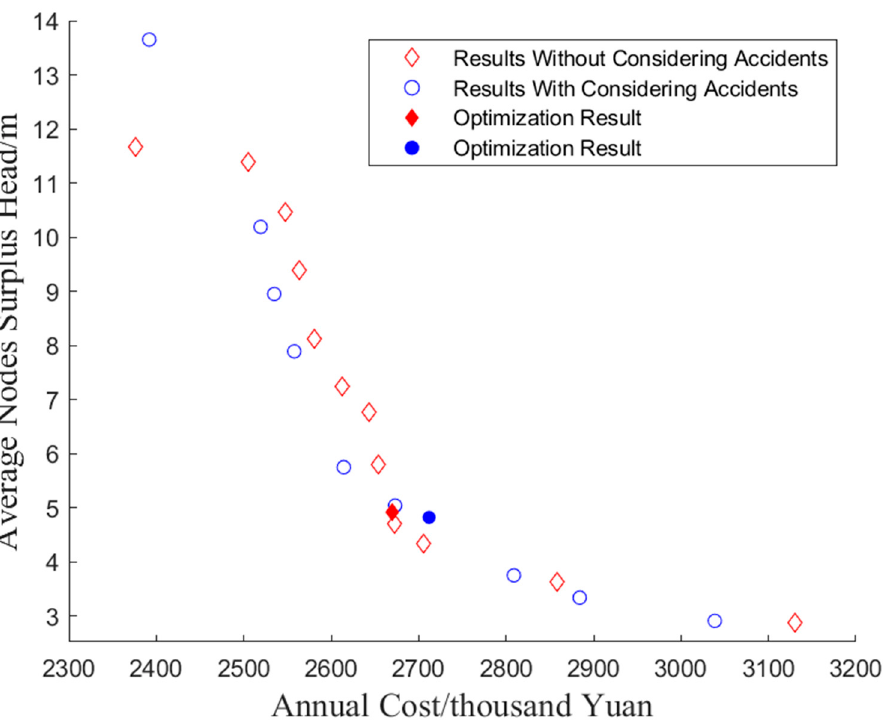
Figure 6. Pareto Diagram of Multi-Objective Optimization Results of a Single Pump Station WDN with and without Considering Accident Conditions.